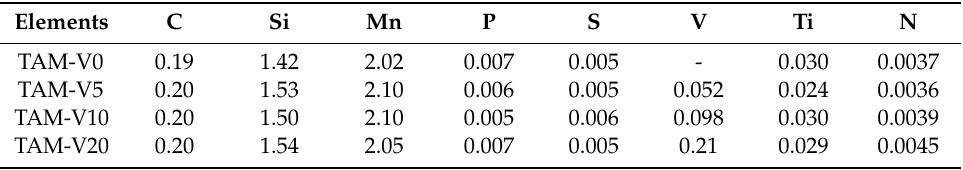
Table 1. Chemical compositions of used steels (wt.